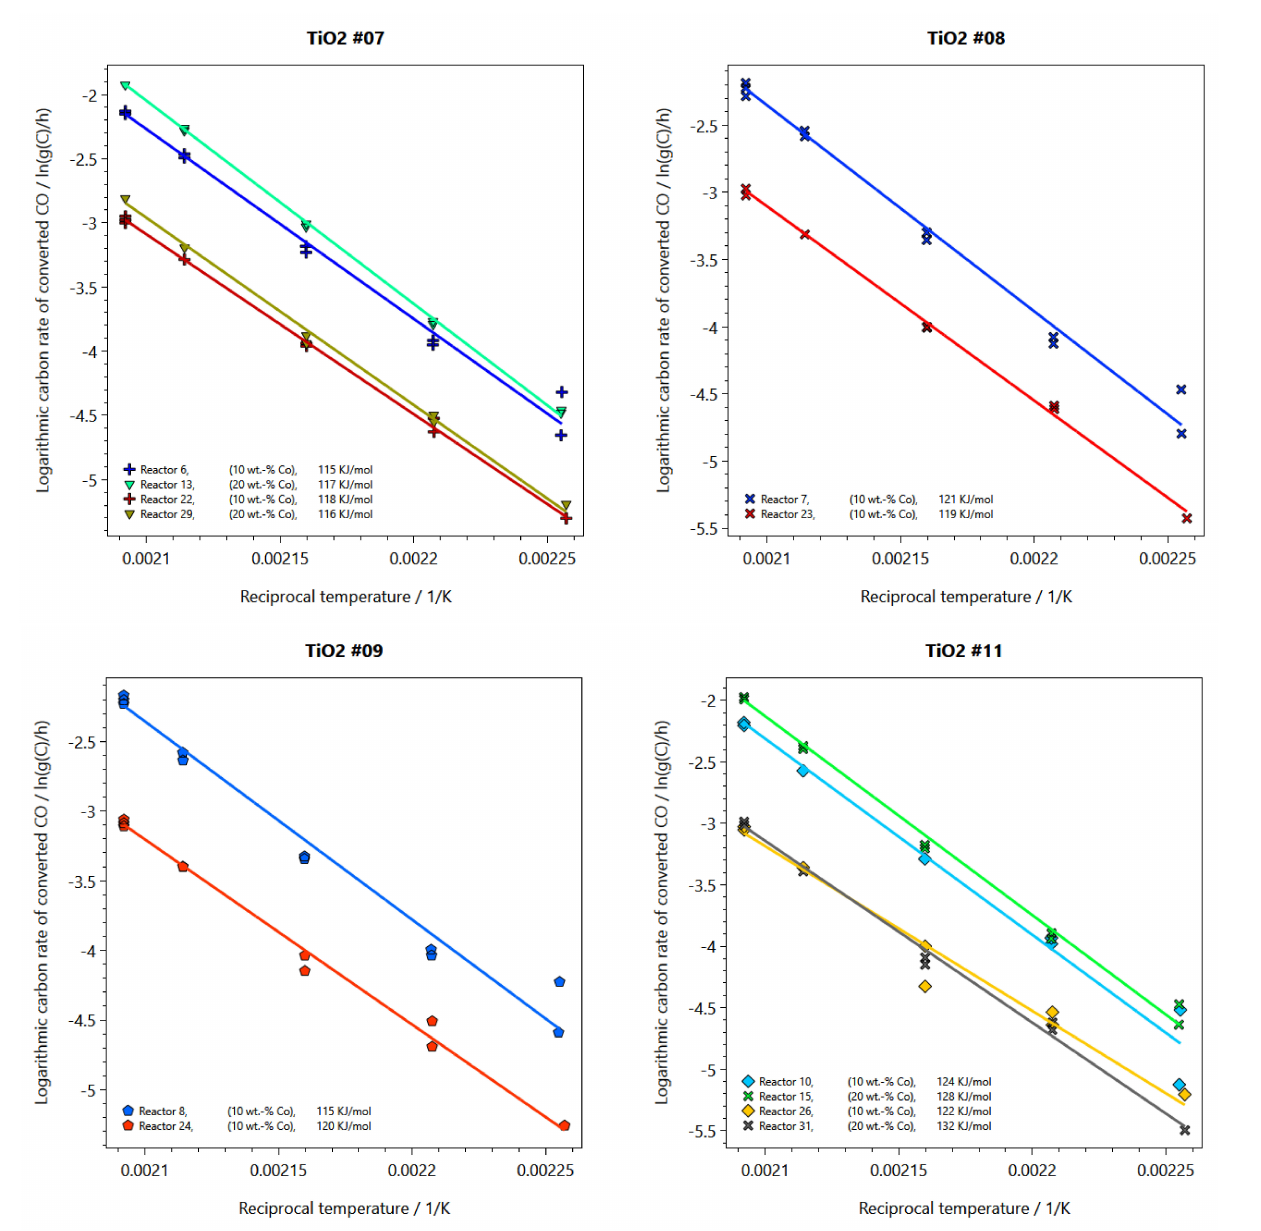
Figure 6. Arrhenius